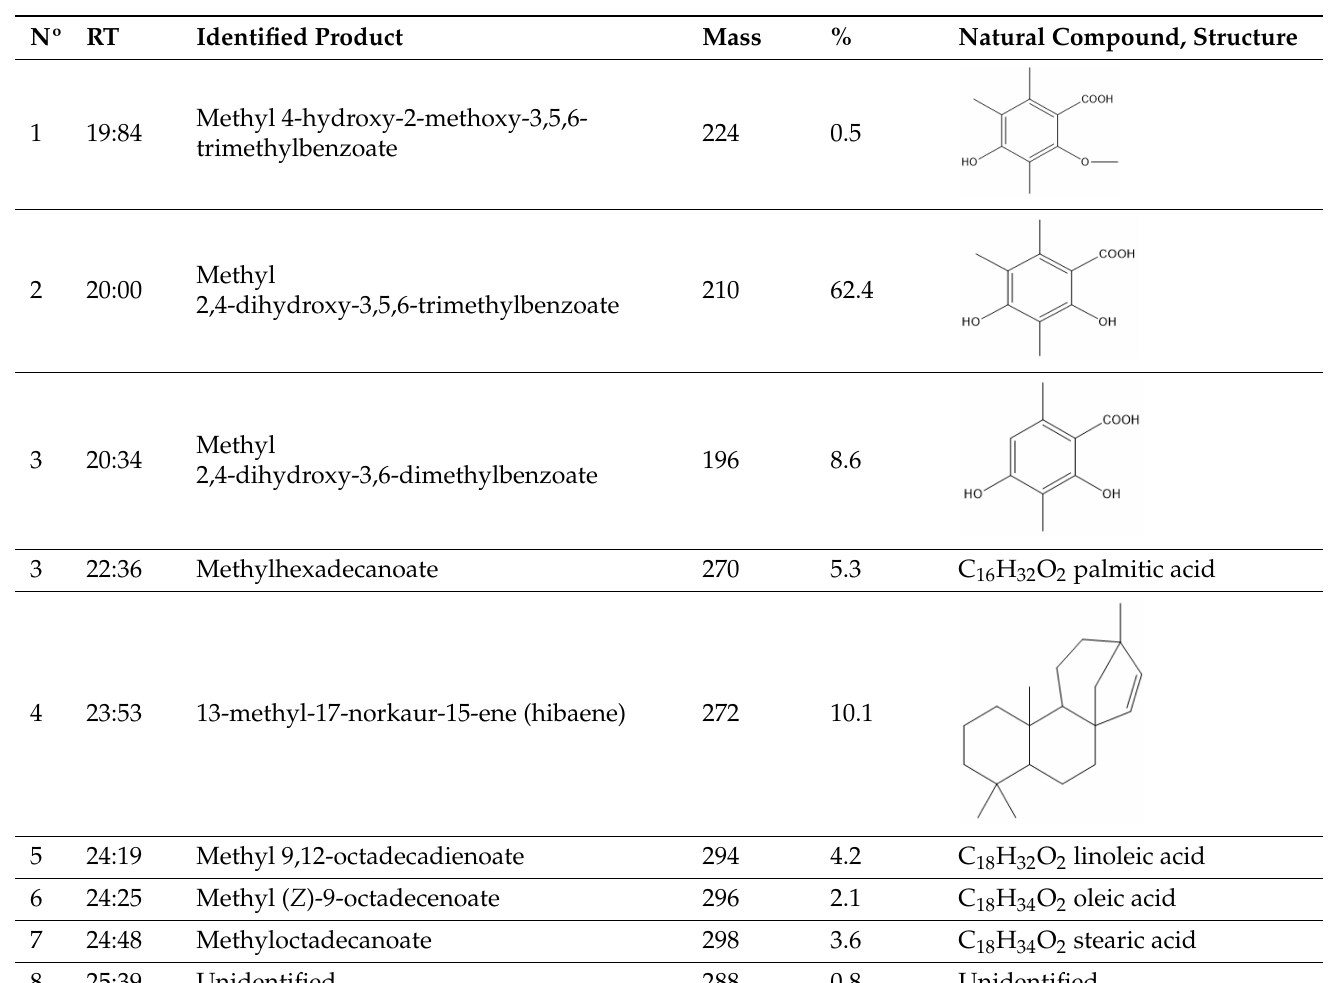
Table 1. Sample Parmotrema hypoleucinum (in Olea europaea ), Hexane extract part soluble in MeOH esterified whit diazomethane, 1-Hexane